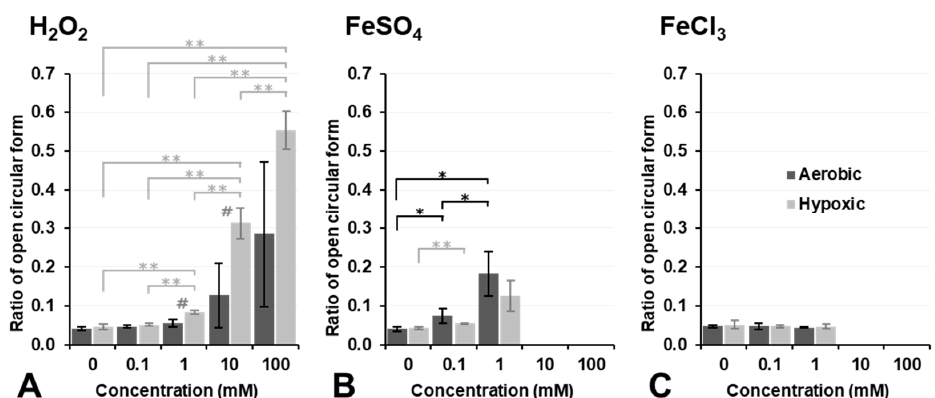
Figure 4. Estimation of plasmid DNA breakage induced by the administration of H 2 O 2 , FeSO 4 , or FeCl 3 alone. Ratio of DNA breakage after reacting with ( A ) H 2 O 2 , ( B ) FeSO 4 , or ( C ) FeCl 3 . Dark and light columns indicate results of aerobic and hypoxic experiments, respectively. Columns and error bars indicate the average and SD of three experiments. Significant differences between different concentrations are indicated in the figure as * and **, which correspond to p < 0.05 and p < 0.01, respectively. # indicates a significant difference of p < 0.05 between aerobic and hypoxic.